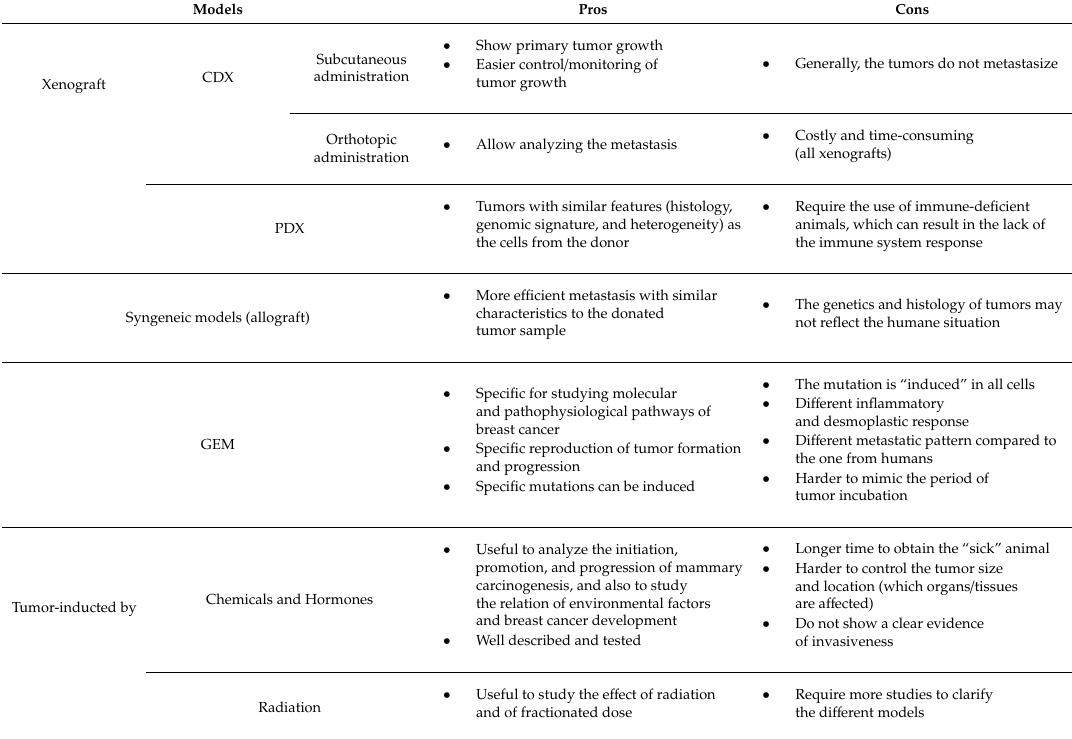
Table 4. Summary table exposing the main advantages and disadvantages identified by the authors for each breast cancer in vivo model mentioned in this review